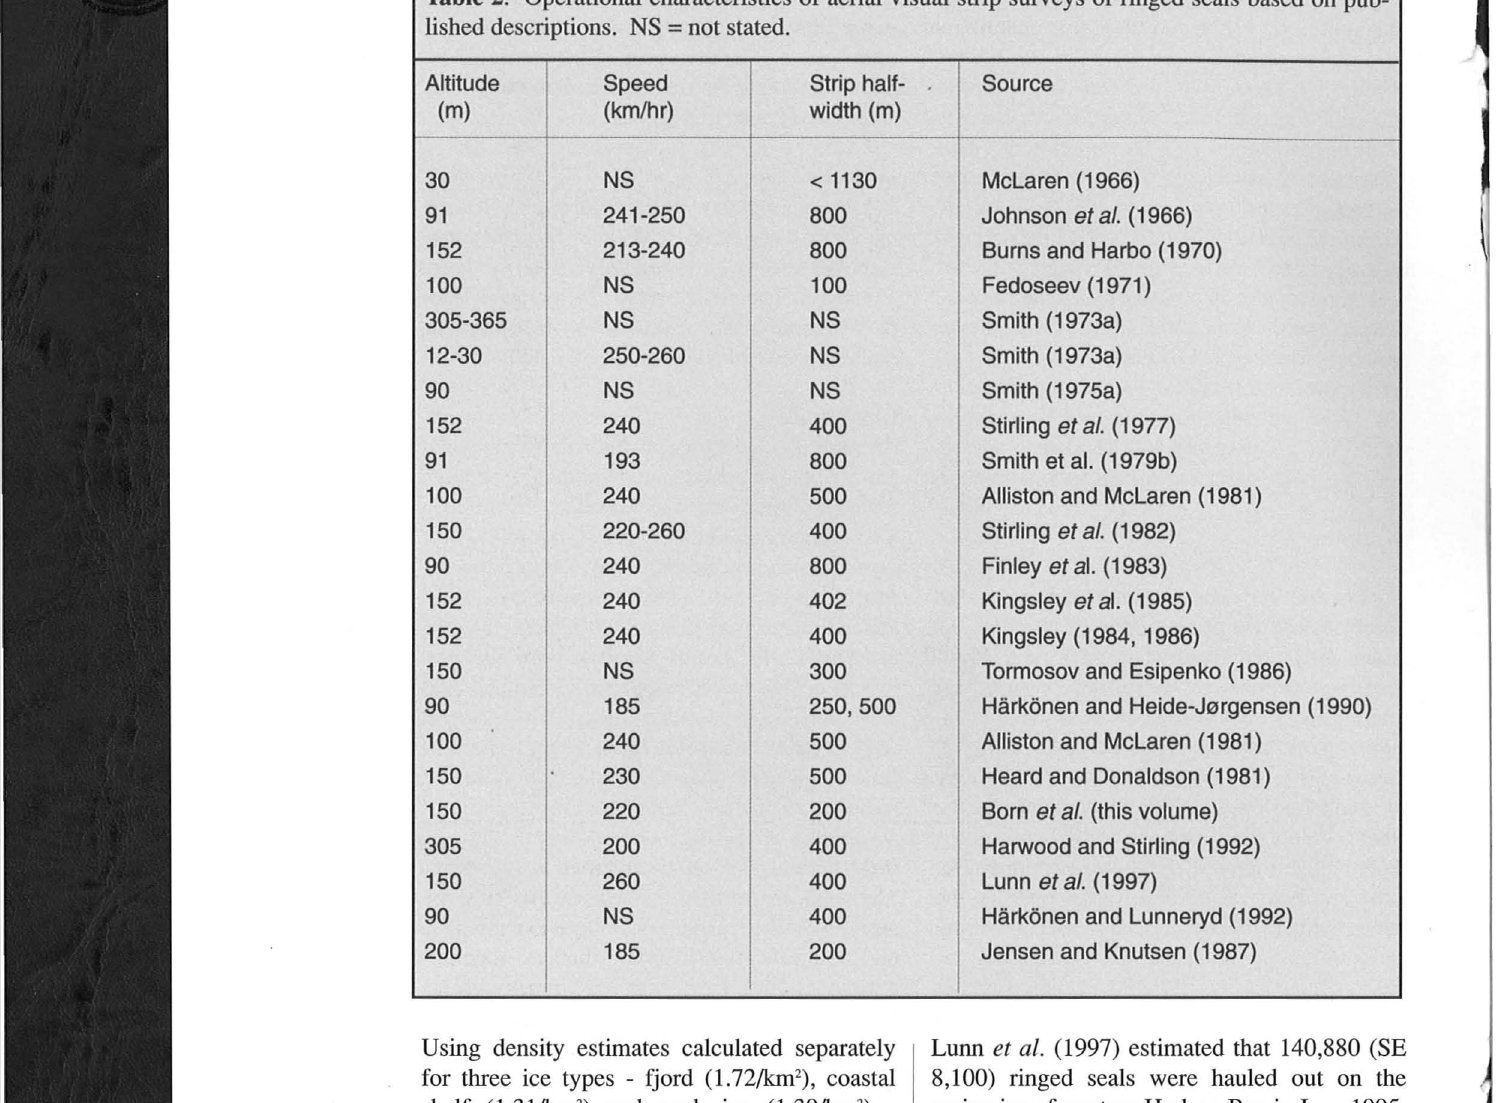
Table 2. Operational characteristics of aerial visual strip surveys of ringed seals based on pub- lished descriptions. NS = not stated. Altitude Speed Strip